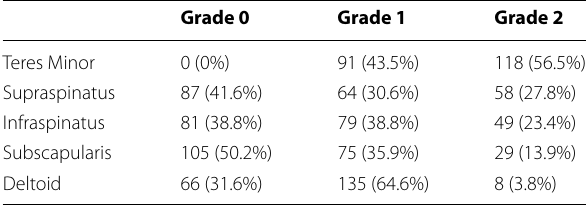
Table 1 Fatty infiltration of the rotator cuff and deltoid muscles based on the Fuchs-Gerber classification